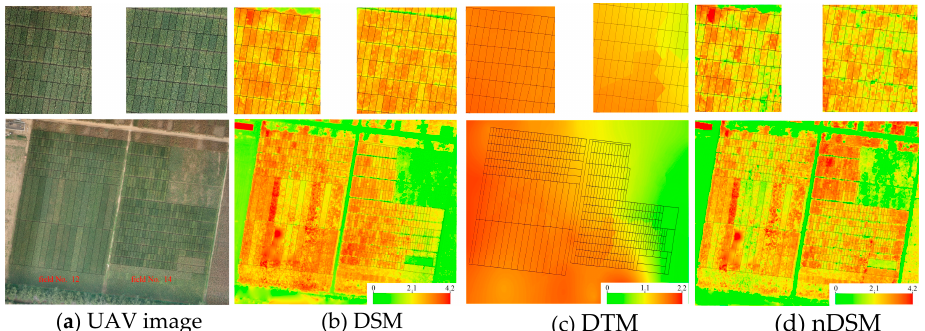
Figure 4. Examples of the images used to estimate corn plant height: ( a ) UAV orthophoto image mosaic, ( b ) digital surface model (DSM), ( c ) digital terrain model (DTM), and ( d ) normalized DTM in the Shunyi breeding trial. Note: the legend is labeled using the heights above the minimum elevation in the study area.